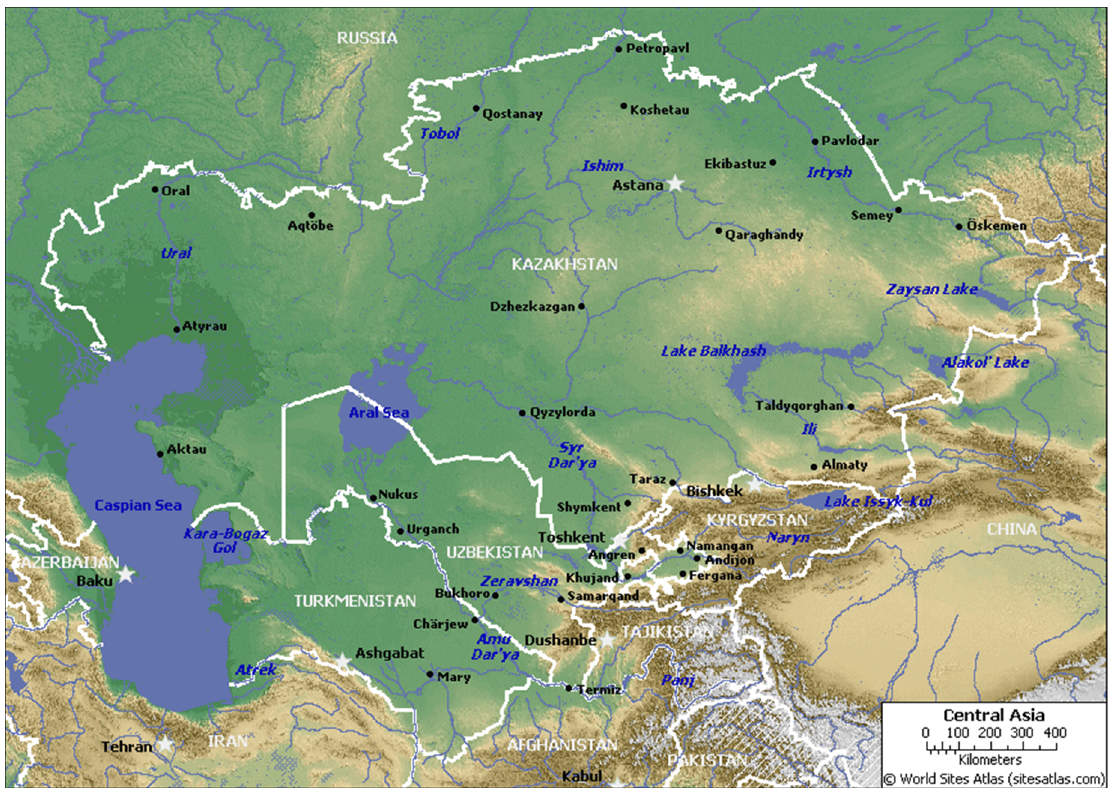
Figure 1. Outline of Central Asia and the five former Soviet Union states Kazakhstan, Turkmenistan, Uzbekistan, Tajikistan, and Kyrgyzstan (courtesy of World Sites Atlas).